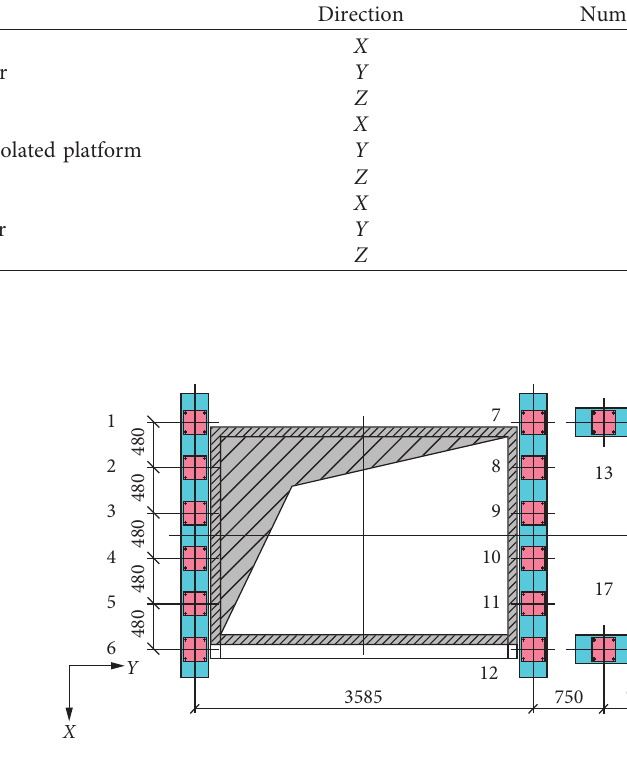
Figure 6: Positions of spring vibration isolators.